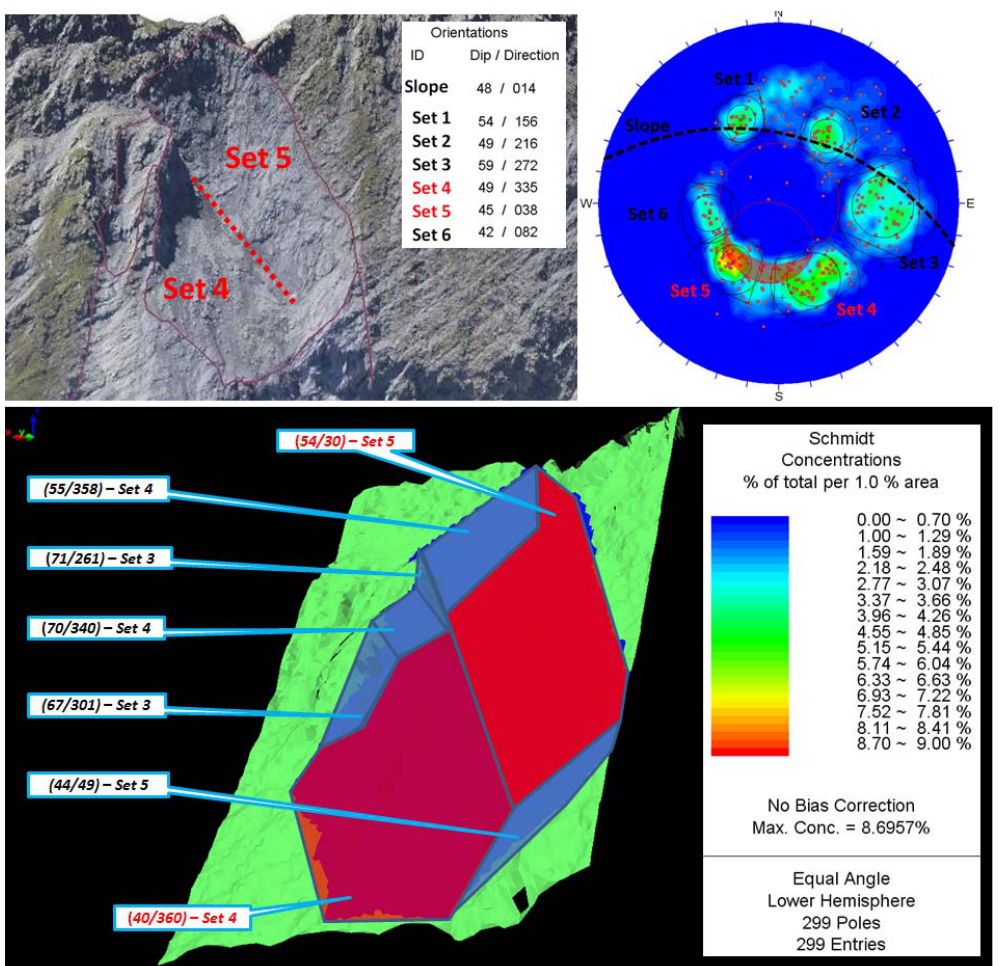
Fig. 10. View of the rock-avalanche detachment area (above, left) and 3-D schematic representation of the 4 main discontinuity sets which probably controlled the landslide (below; dip direction/dip are in degrees). Above right: stereoplot (Equal Area, Lower Hemisphere), with the poles of the 7 main discontinuity sets identified in the study area after processing the LiDAR point cloud; dashed black line: local orientation of the slope before the landslide occurrence (48/18); red area: planar sliding zone; set 1: schistosity; a friction angle of 37 ◦ was assumed for the kinematic